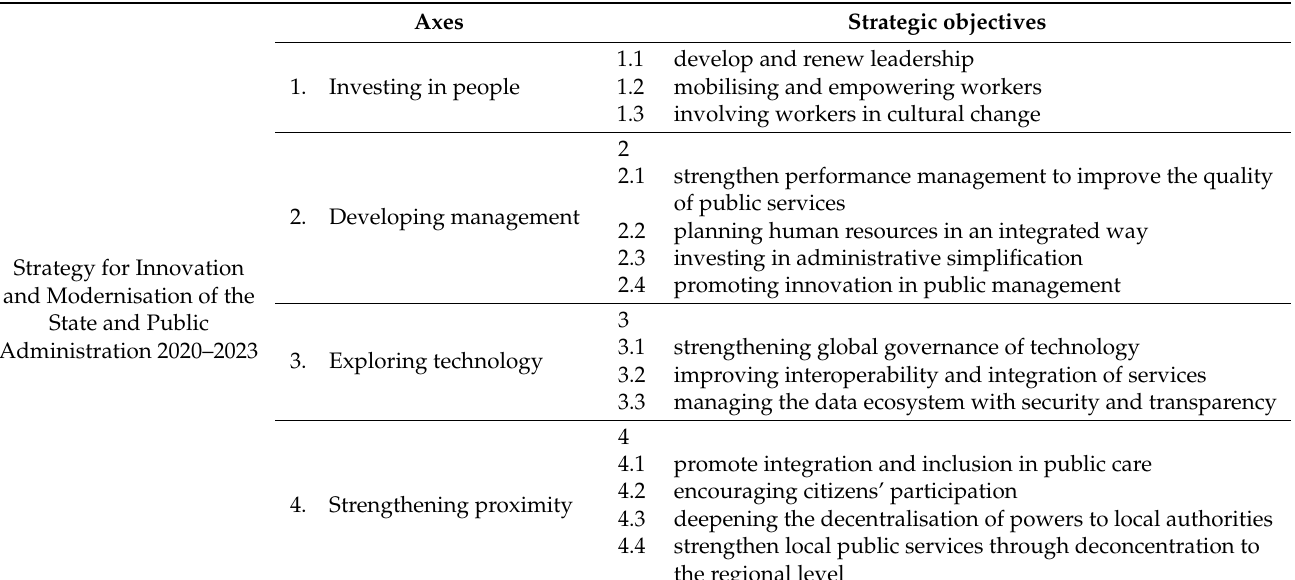
Table 1. Strategy for Innovation and Modernisation of the State and Public Administration 2020–2023.